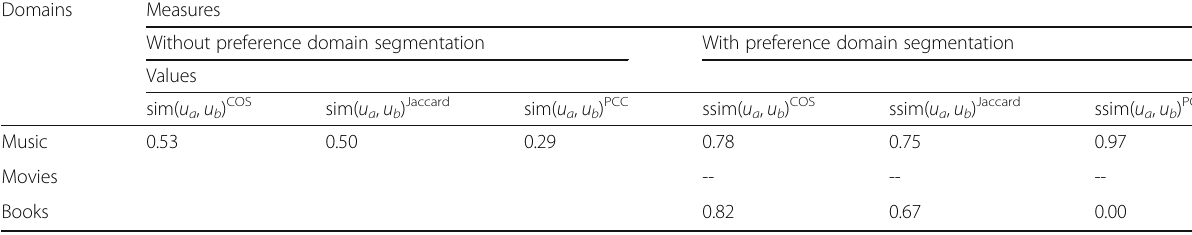
Table 2 Comparison of preference